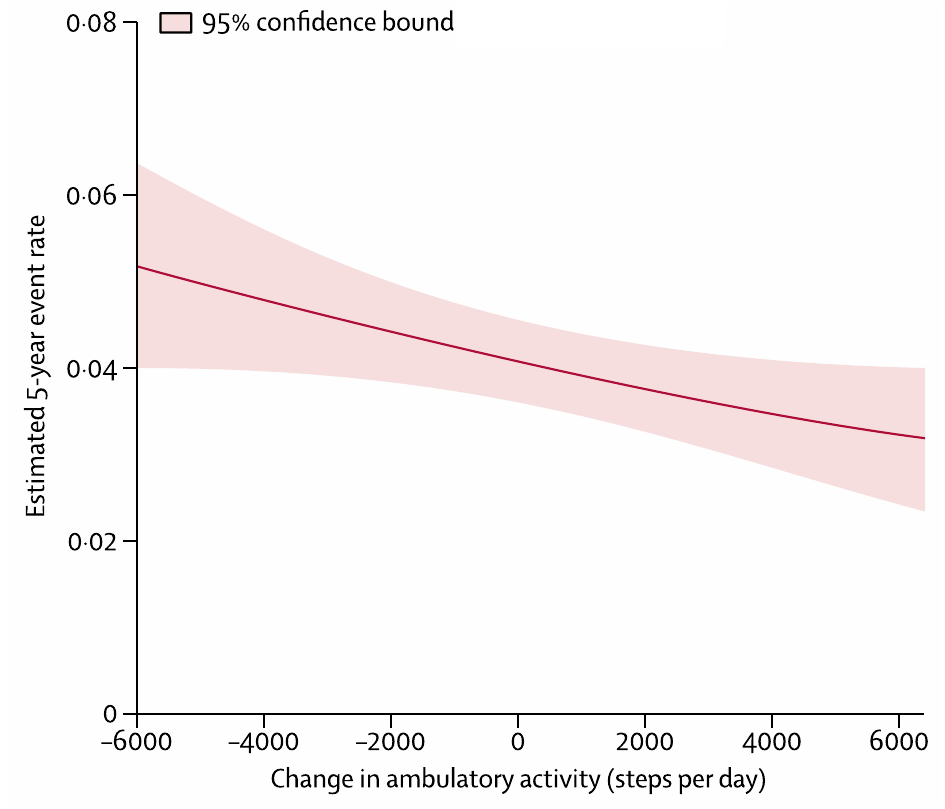
Figure F1-1. Association Between Change in Daily Step Count and Cardiovascular Events in Individuals with Impaired Glucose